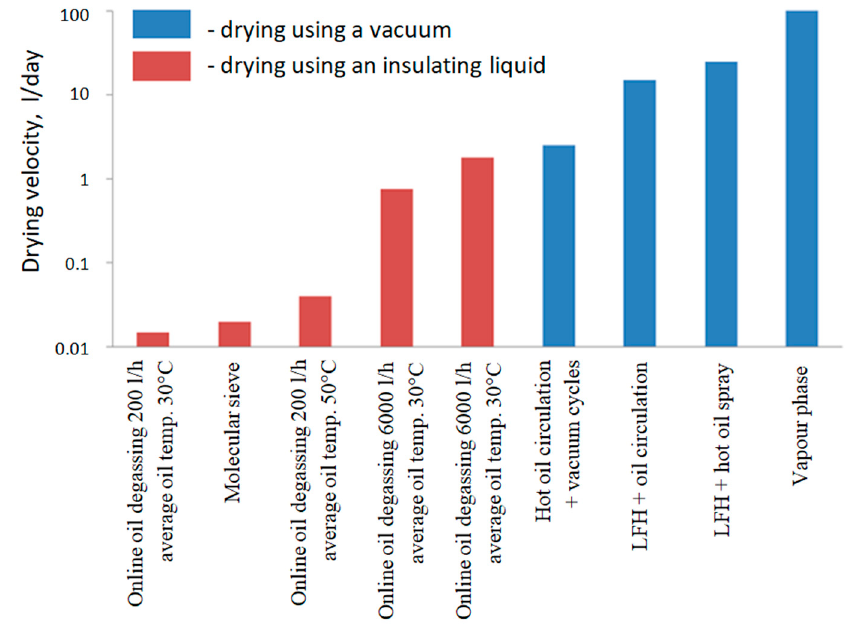
Figure 1. Drying velocity expressed in liters of water removed in one day by means of different methods from transformer solid insulation (400 MVA, cellulose insulation weight—14 tons) from 3% to 1.5% average moisture (based on [32,42]). LFH—Low Frequency Heating.